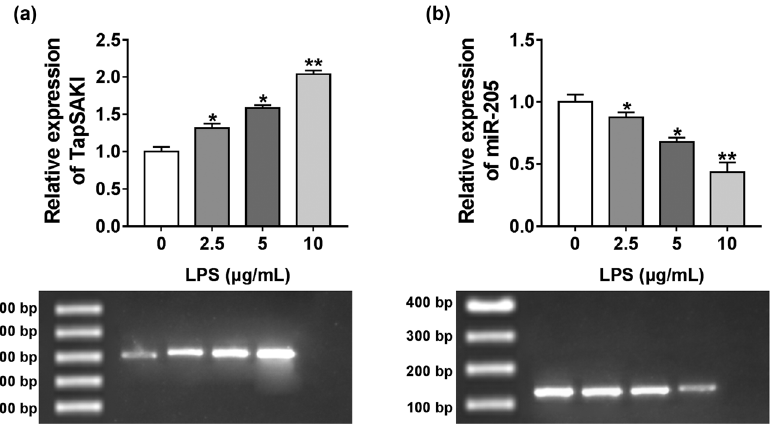
Figure 2: TapSAKI was upregulated and miR - 205 was downregulated in HK - 2 cells after LPS stimulation. TapSAKI ( a ) and miR - 205 ( b ) expression levels by qRT - PCR and agarose gel electrophoresis assay in HK - 2 cells after stimulation with various concentrations ( 0, 2.5, 5, and 10 µg/mL ) of LPS for 48 h. * P < 0.05, ** P < 0.01.